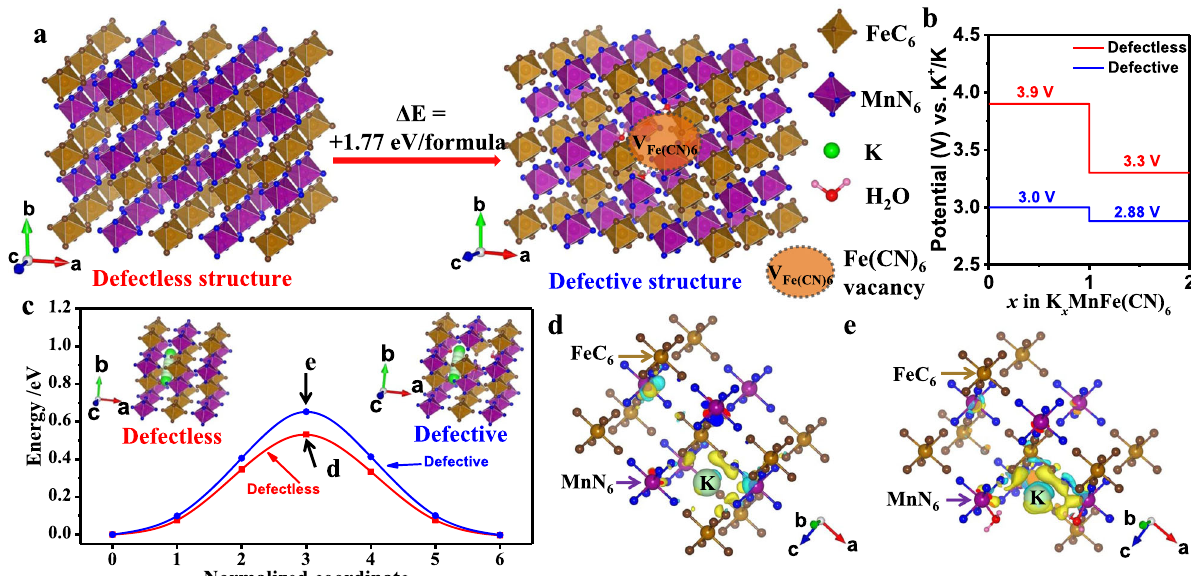
Fig. 4 First-principles calculations. a The calculated formation energy of the defective structure with defects and water in KMF. The K atoms and C ≡ N bonds are omitted for clarity. b The calculated voltage plateaus for the KMF with defectless and defective structures. c Migration energy barriers of the K- ions diffusion within the lattice of the KMF with defectless and defective structures. The insets in c show the calculated K-ion migration paths. d , e The differential charge density diagram of the d defectless structure and e defective structure in the transition state marked in c . The yellow and cerulean region represent the electron-rich and electron-poor area, respectively. The corresponding valence states of K ion in d and e are listed in Supplementary Table